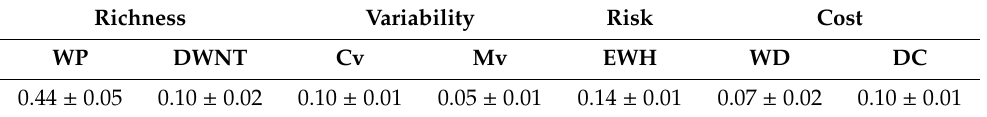
Table 6. Weight coe ffi cient in the wave energy classification. Factors averaged to the fifteen wave energy experts and engineers consulted. The standard deviation was calculated as σ = where A is the weight coe ffi cient, A is the mean value of A and N is the number of experts